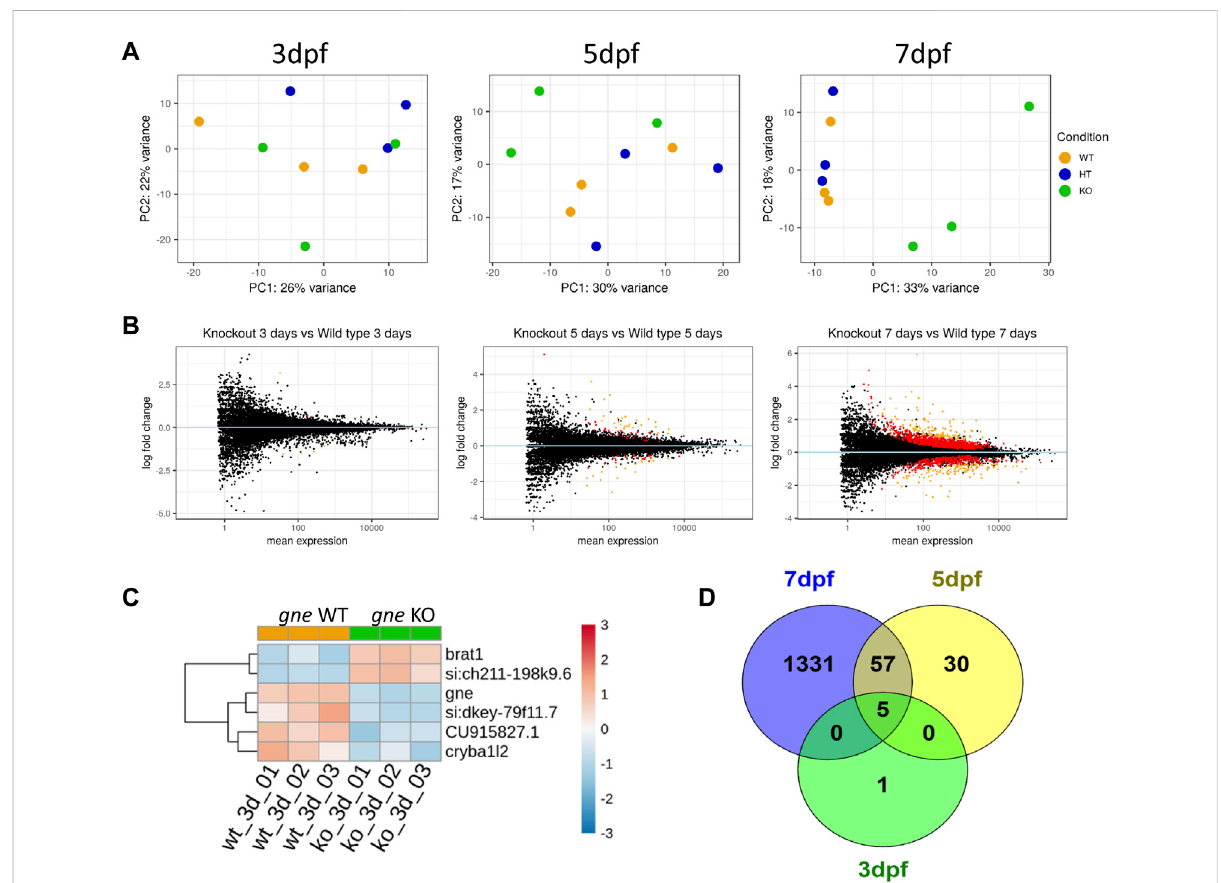
FIGURE 9 Transcriptomics analysis of gne KO larvae. (A) PCA plots of gne KO vs. gne WT at 3 dpf, 5 dpf and 7 dpf. gne KO cluster separates from gne WT and gne HT from 5 dpf onwards. (B) MA plots of gne KO vs . gne WT at 3, 5 and 7 dpf. Red and orange dots refer to signi fi cant differentially expressed genes, black dots are for non-signi fi cant genes. (C) Hierarchical classi fi cation of DE genes in gne WT versus gne KO at 3 dpf (3 biological replicates). The fi gurepresentsupregulated(red)anddownregulated(blue)genes.(CU915827.1=si:dkey31e10.5). (D) Venndiagramindicatingthenumber of signi fi cant differentially expressed genes among gne KO and gne WT siblings at 3 (green), 5 (yellow) and 7 (blue)